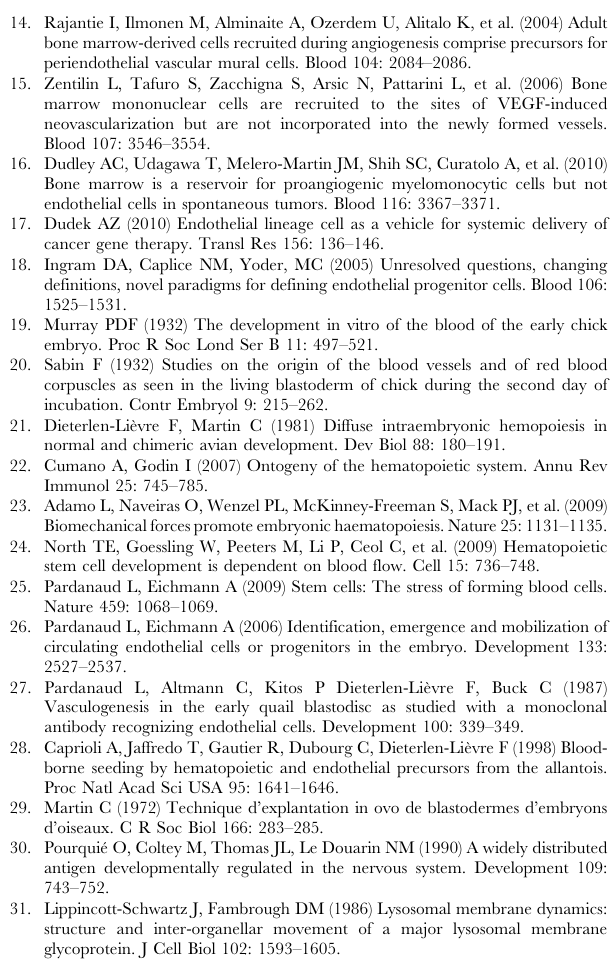
QH1 + cells among a majority of QH1 2 /8F3 2 quail population. Bar: 20 mm. B) Two 8F3 + /LEA 2 chick cells (arrows) and two 8F3 2 /LEA + quail macrophages (arrowheads) are visible in this field. C) QH/BEN staining identifies double stained HC and Figure S2 Distribution of chick yolk sac-born macro- phages in E15 quail chimeras. A) In toto double immuno- staining showing 8F3 + cells (green) invading the QH1 + vascular plexus of the pia mater. Bar: 20 mm. B) High magnification of a 8F3 + cell showing a thin filopodial extension (arrow) towards the vascular plexus. Bar: 7 mm. C) Triple staining on a section through the pia mater identifying a chick QH1 2 /Sambucus + / LEP100 + macrophage (arrow) among QH1 + HC (arrowheads). Bar: 20 mm. D) In toto double immunostaining in the skin showing a chick cell (arrowhead) present among QH1 + cells. Bar: 20 mm. E) Skin section with a triple staining identifying a chick QH1 2 /Sambucus + /LEP100 + macrophage (arrow) among QH1 + HC (arrowheads). Bar: 20 mm. F) Transverse section through the heart with two chick QH1 2 /Sambucus + /LEP100 + macrophages (arrows) close to a QH1 + coronary vessel (V). Bar: 20 mm. G–I) In toto QH1/8F3 double staining in large vessels does not identify 8F3 + chick cells in the quail aortic endothelium (G), the quail aortic vasa vasorum (H) and the quail jugular vein endothelium (I).